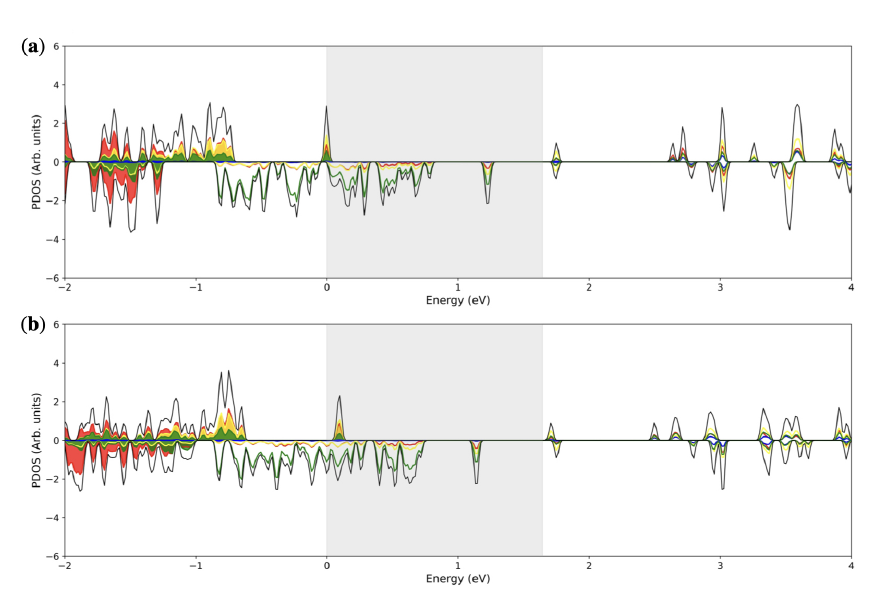
Figure 9. PDOS ( a ) α 12 and ( b ) β 12 systems (i.e., p = 0.75) (copper = red, sulfur = yellow, aluminium = blue and iron = green).